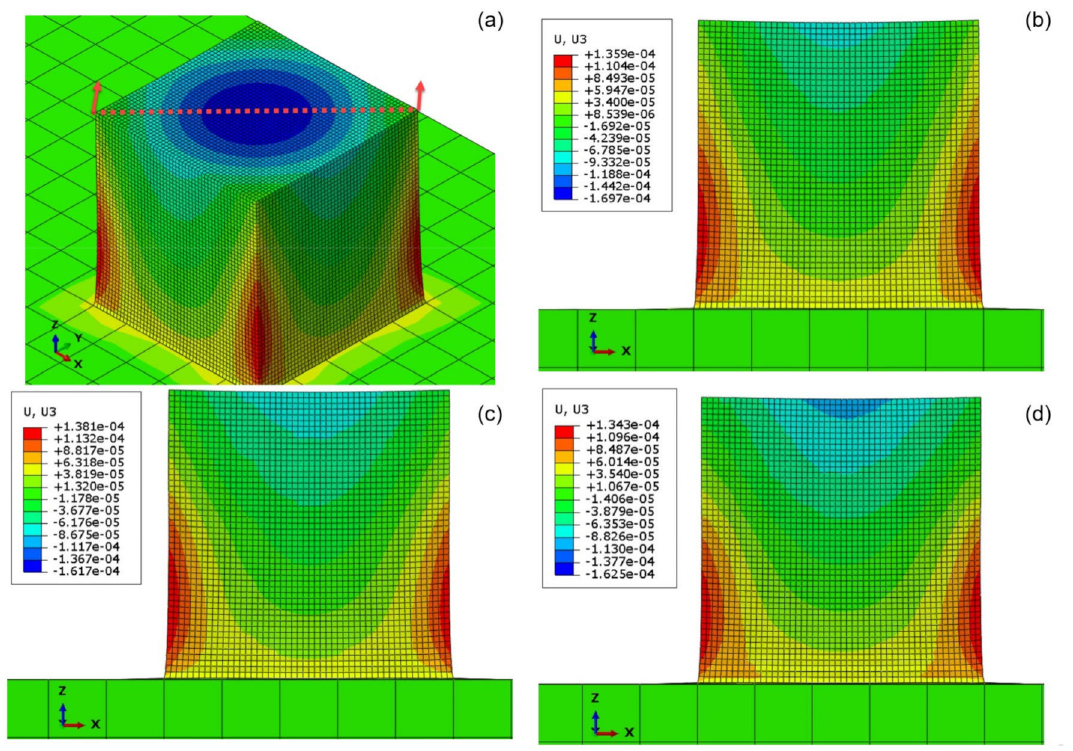
Figure 48. Deflection in Z direction at 650 mm/s, 0.12 mm, and ( a ) diagonal direction, ( b ) 140 W, ( c ) 220 W, and ( d ) 270